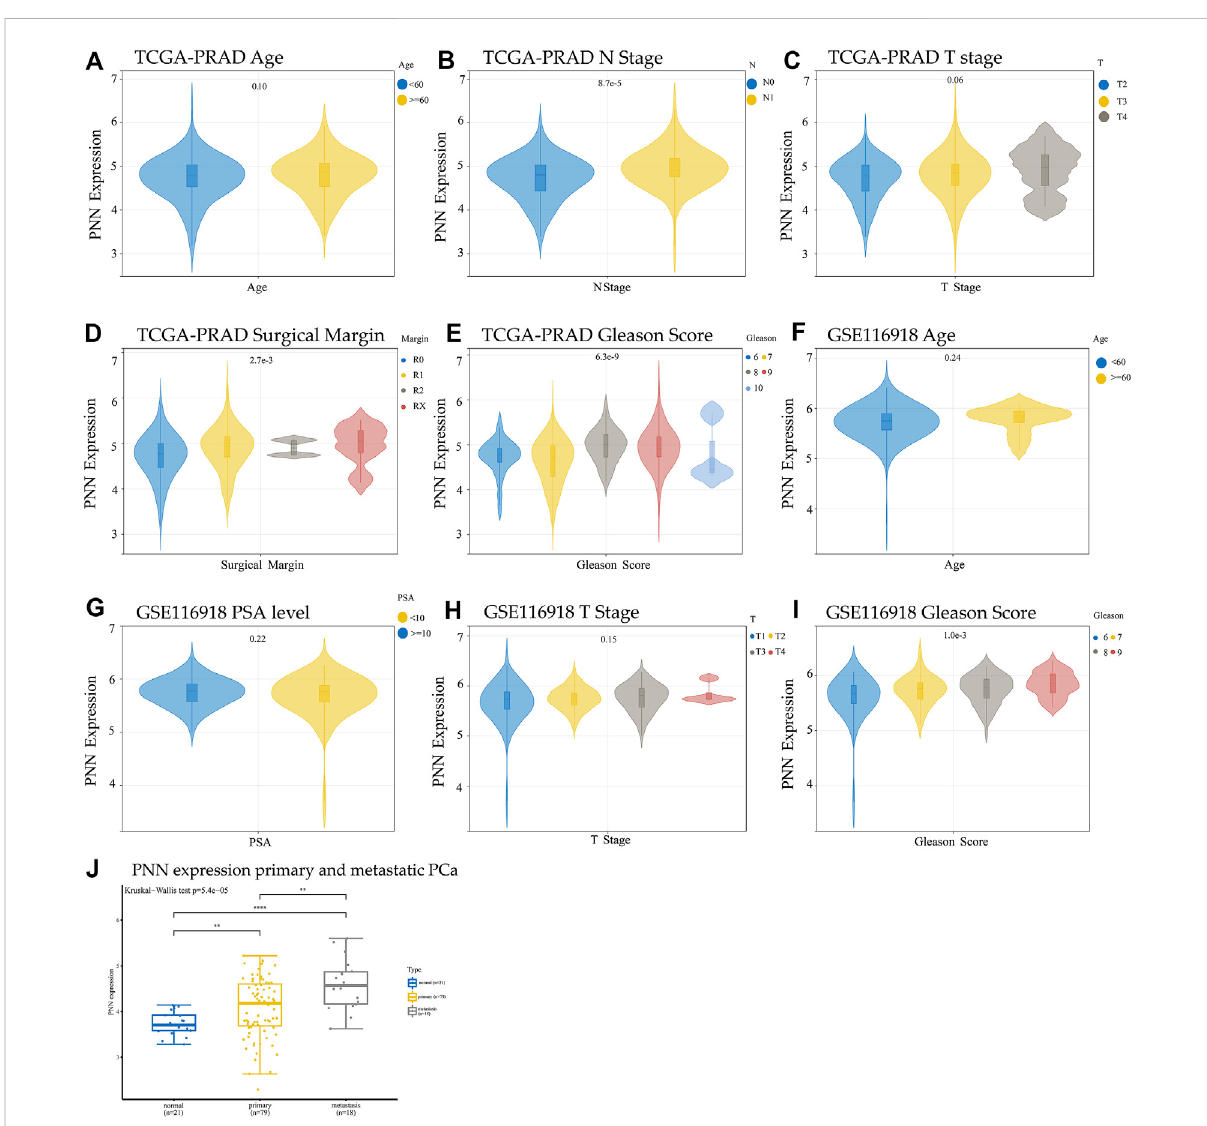
FIGURE 3 Comparison of PNN expression and clinical information in TCGA (A) Age, (B) N stage, (C) T stage, (D) Surgical margin, and (E) Gleason score. Comparison of PNN expressionandclinicalinformationofGSE116918 (F) Age, (G) PSAlevel, (H) Tstage,and (I) Gleasonscore.The t -testwasusedto evaluate the difference between two groups, and analysis of variance (ANOVA) was used to compare data divided into more than two groups. (J) Comparisionofthe PNN geneexpressionbetweenprimaryandmetastaticPCausingGSE38241andGSE25136datasetsfollowingbatcheffects